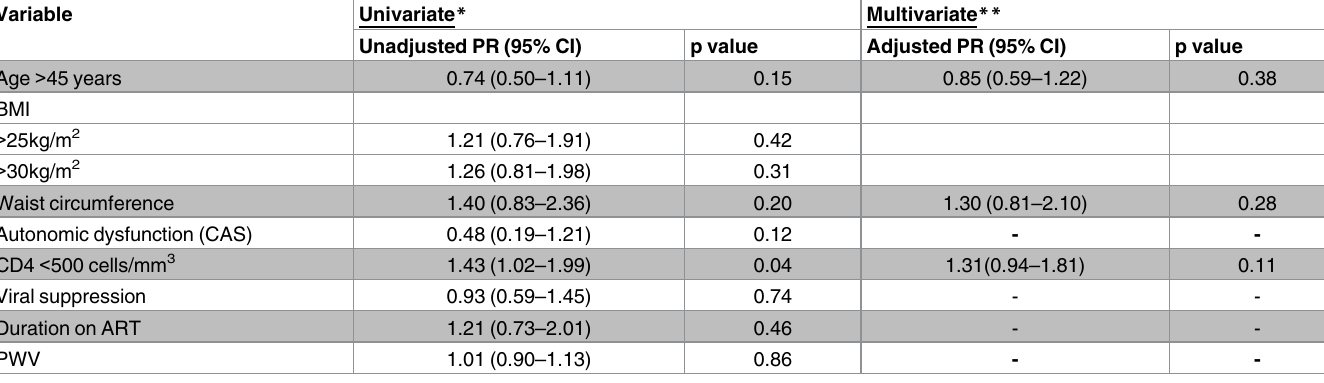
Table 4. Unadjusted and adjusted PR for prevalent risk factors associated with non-dipping